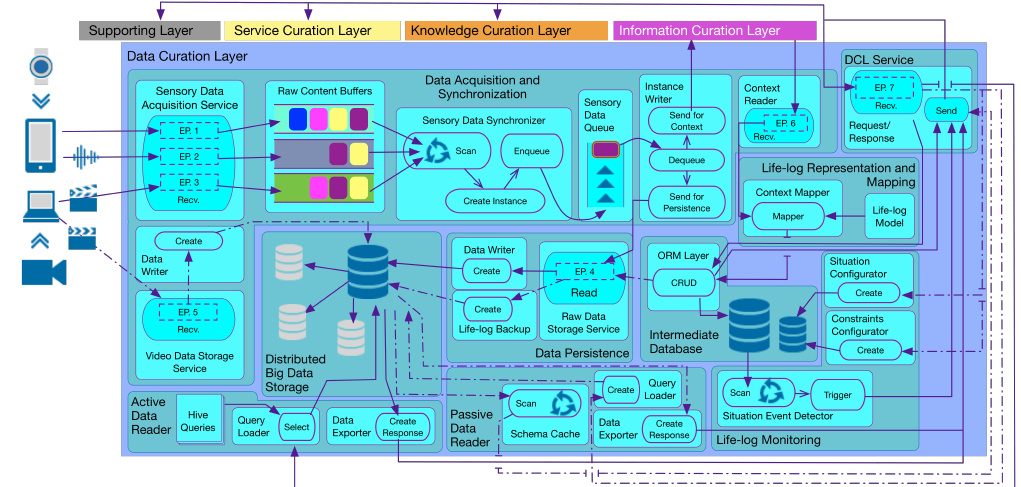
Figure 6. DCF execution